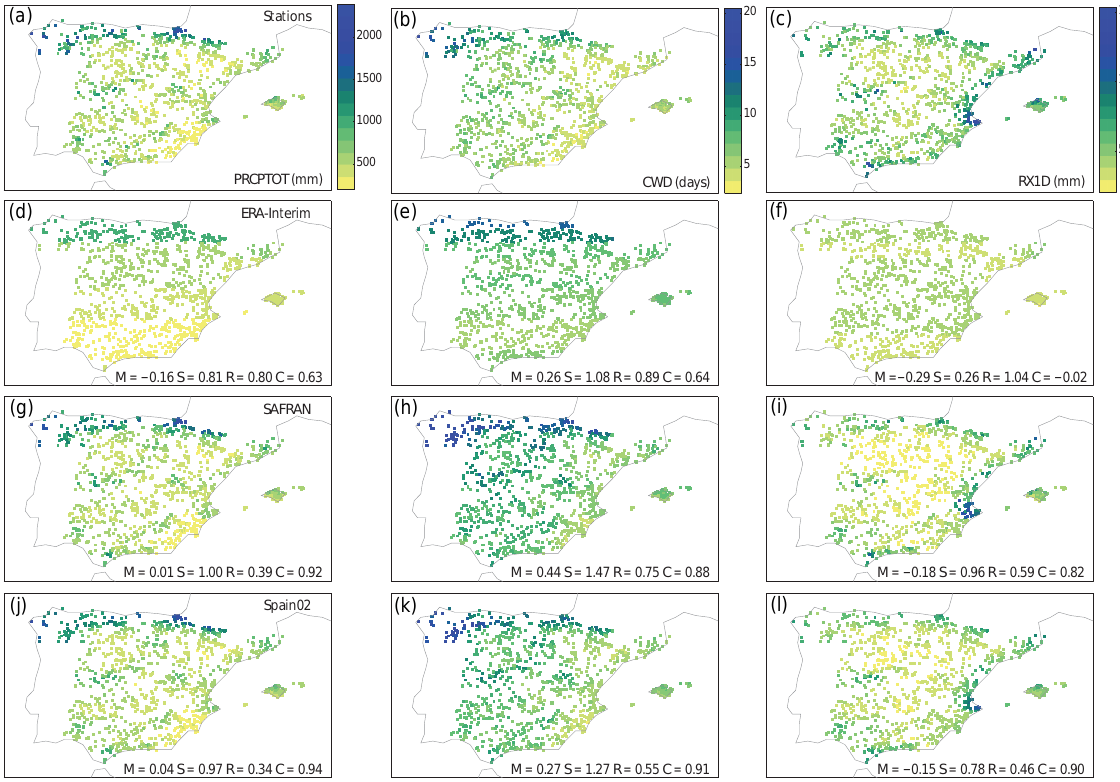
Figure 5. The PRCPTOT (a, d, g, j) , CWD (b, e, h, k) and RX1D (c, f, i, l) for the stations (a–c) , ERA-Interim (d–f) , SAFRAN (g–i) and Spain02 (j–l)